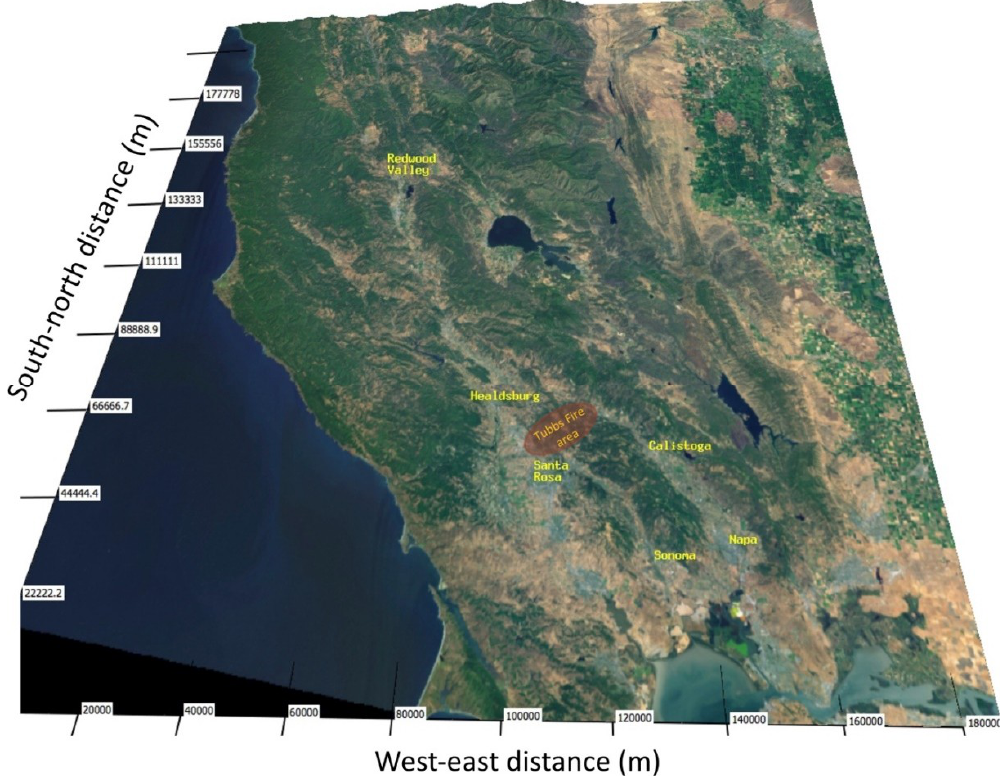
Figure 7. The geographical extent of modeling domain 3.